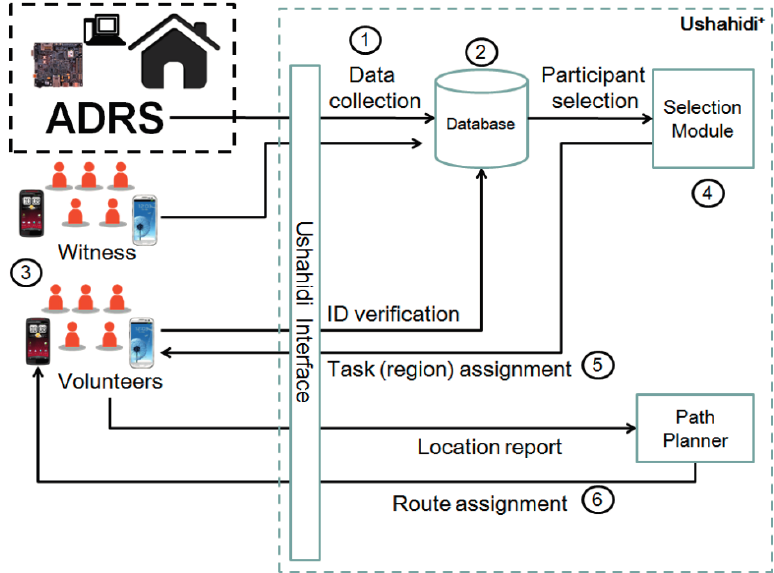
Figure 9. The relationship between ADRS and a crowdsourcing-enhanced emergency management